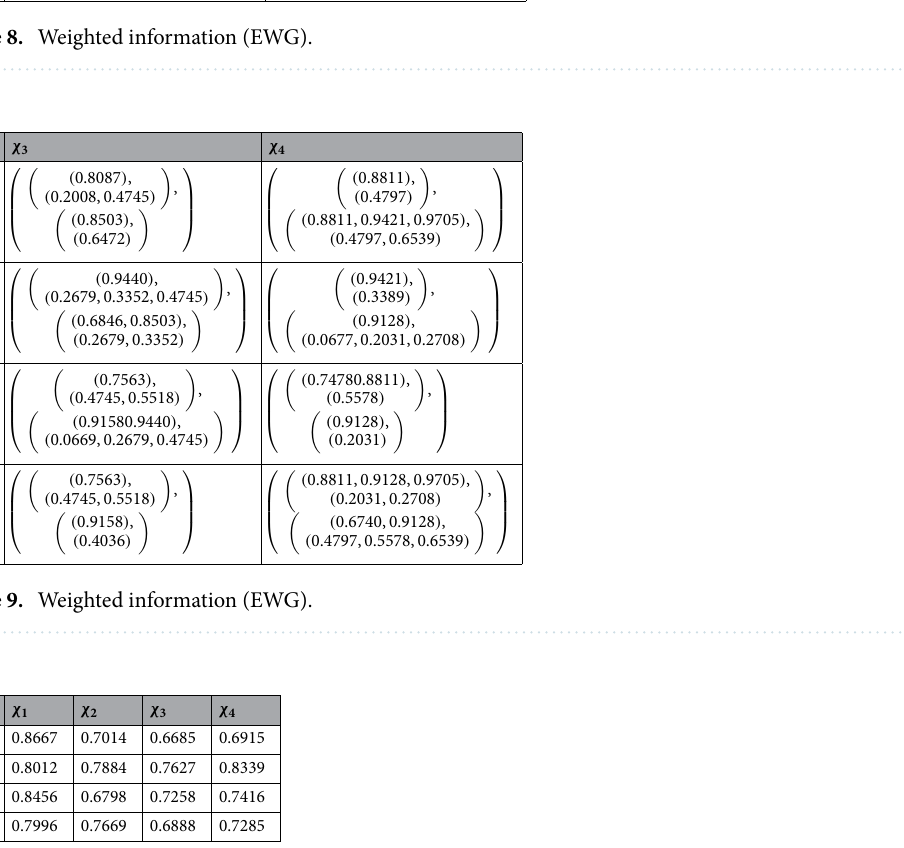
Table 10. Score value of weighted (EWG)